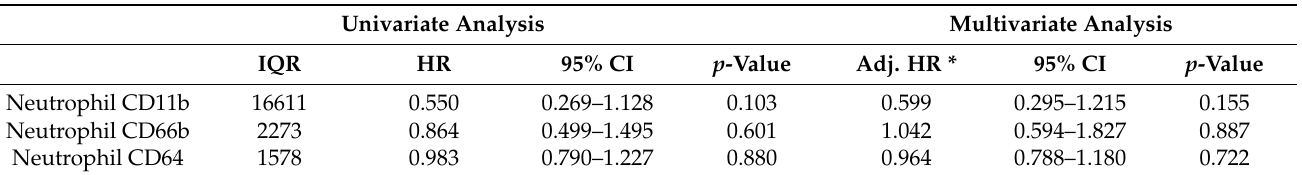
Table 2. Univariate and multivariate Cox regression analysis of the association between the neutrophil markers CD11b, CD66b and CD64 and all-cause mortality.